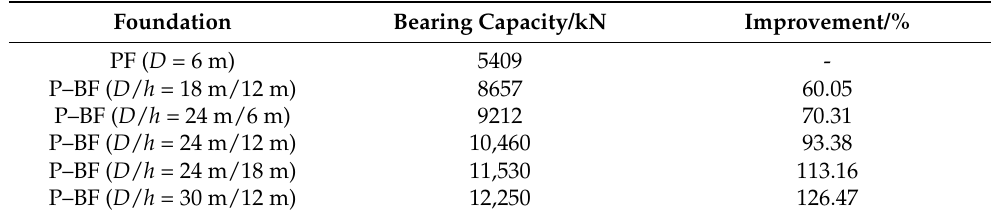
Table 6. The increment of bearing